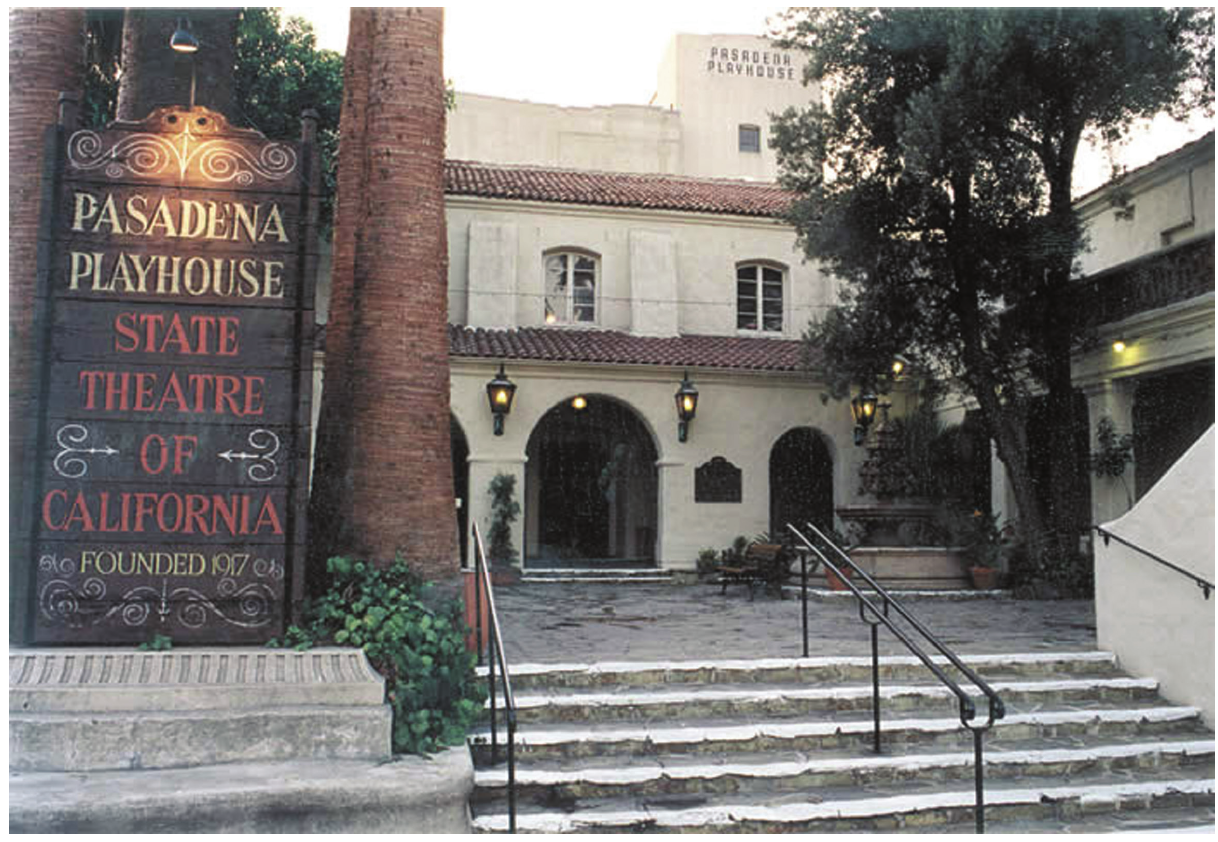
Figure 2. The Pasadena Playhouse College of Theatre Arts, the venue for Arzner’s first collegiate-level film-making courses (Source: Wikimedia